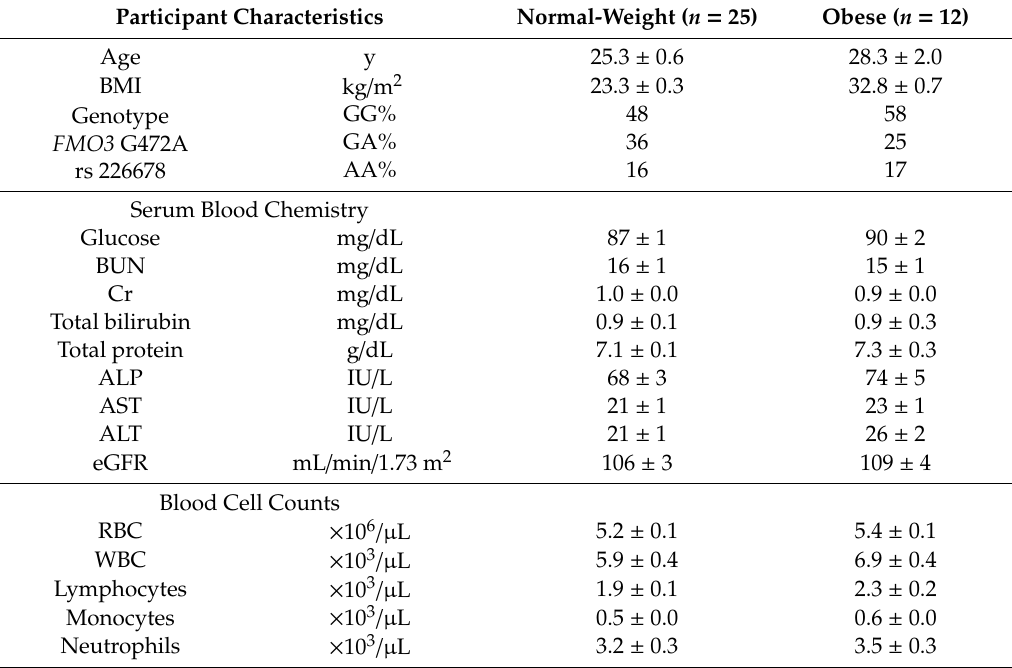
Table 1. Participant characteristics for normal-weight ( n = 25) and obese ( n = 12)